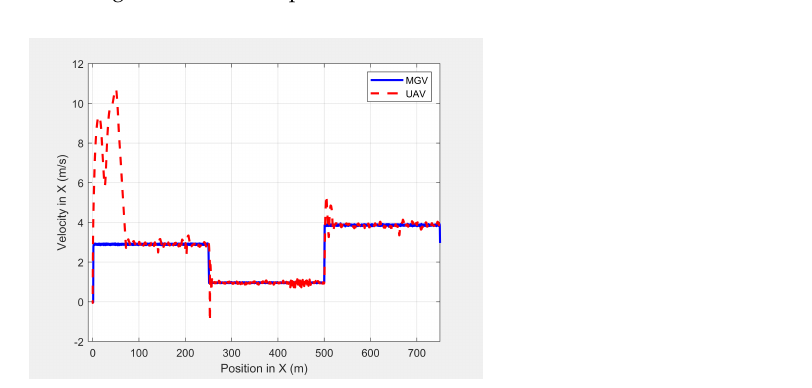
Figure 21. The UAV’s velocity in the horizontal direction when following the MGV while moving at varying velocities in the presence of static obstacles.